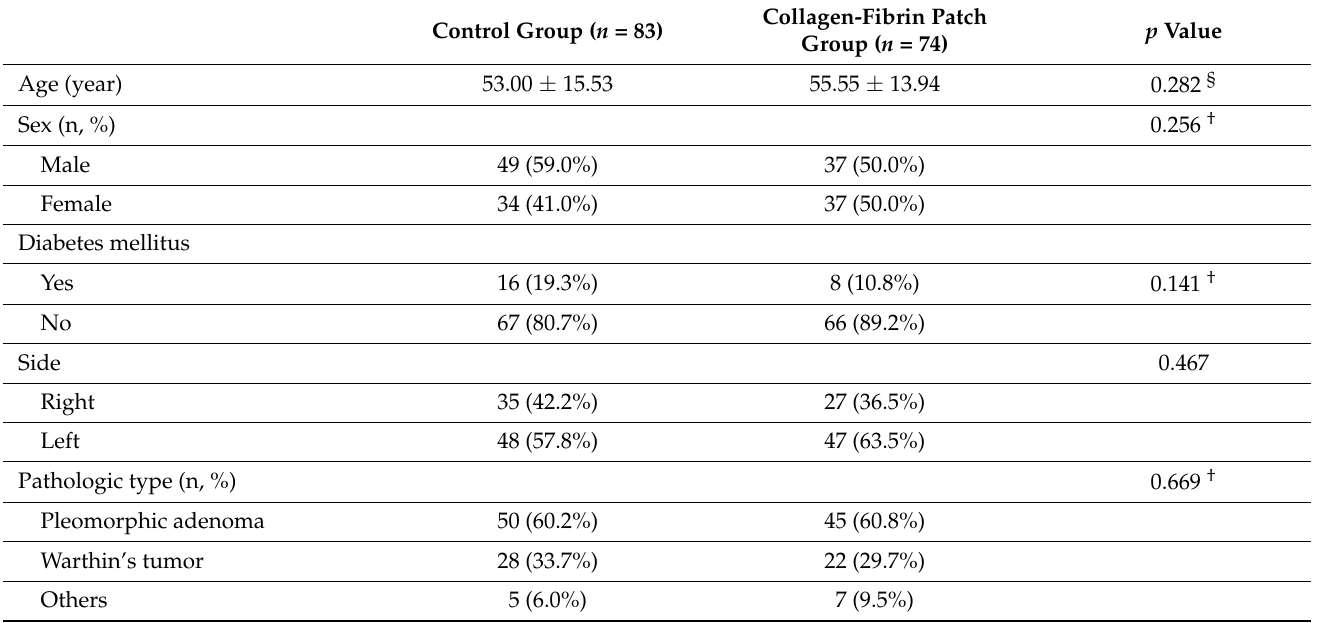
Table 1. Baseline patient